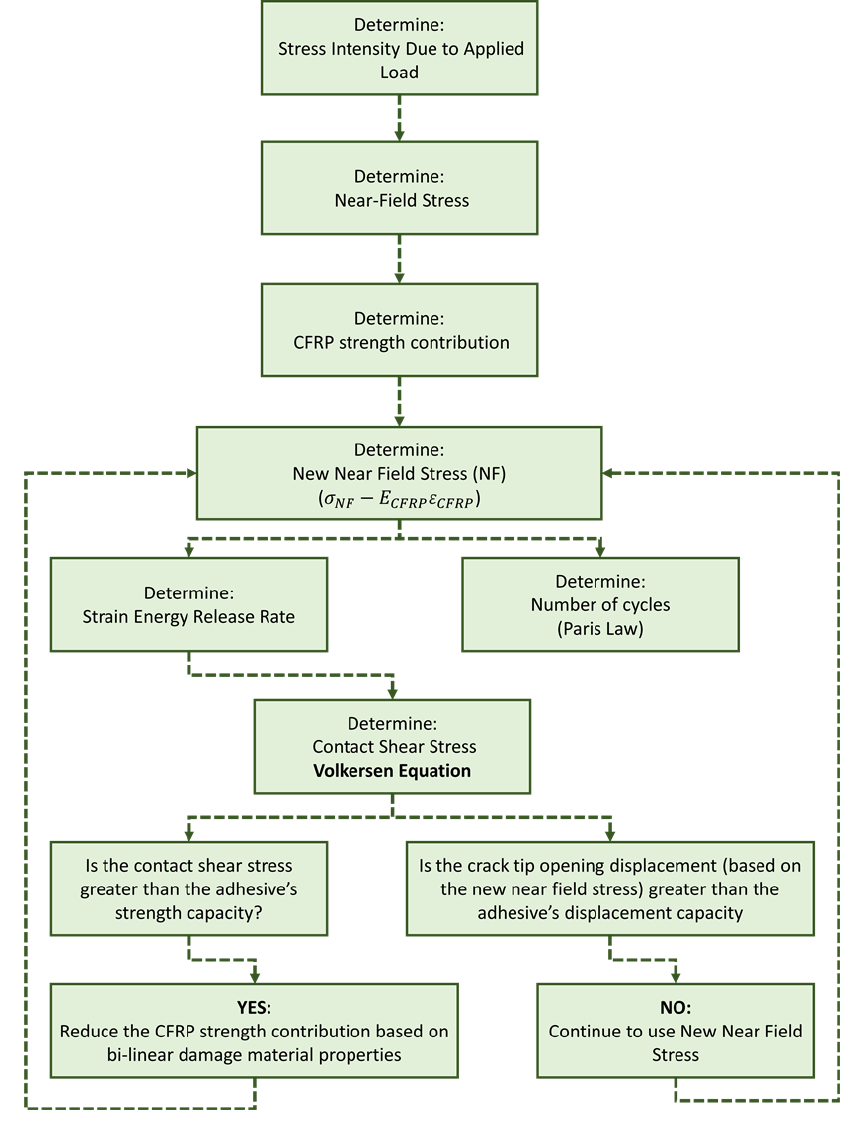
Figure 5. Algorithm of analytical model.